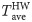
Simulated population curves by the MPAD model under different heat wave scenarios: (a) different OHW (before DOY 192), (b) different OHW (after DOY 192), (c) different DHW, and (d) different TaveHW. The black curve represents the population abundance under the non-heat wave scenario, where the peak is identified at DOY 192.